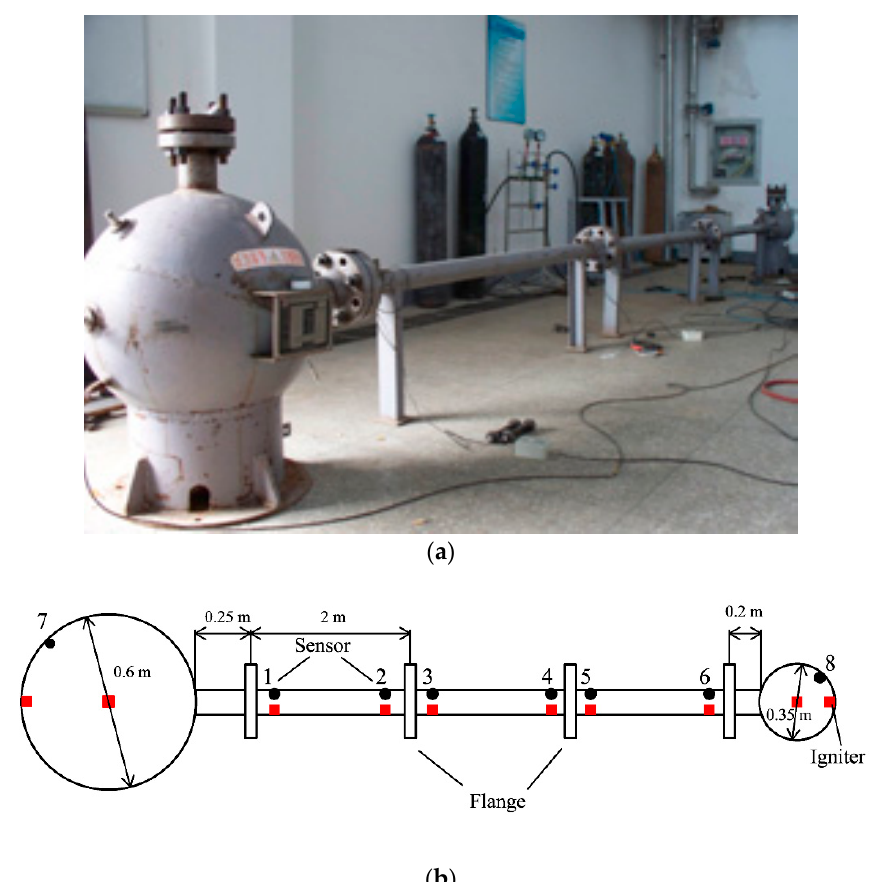
Figure 1. Picture and schematic diagram of the experimental device for the gas explosion. ( a ) Photo of the experimental device; ( b ) scheme structural diagram of linked vessels.